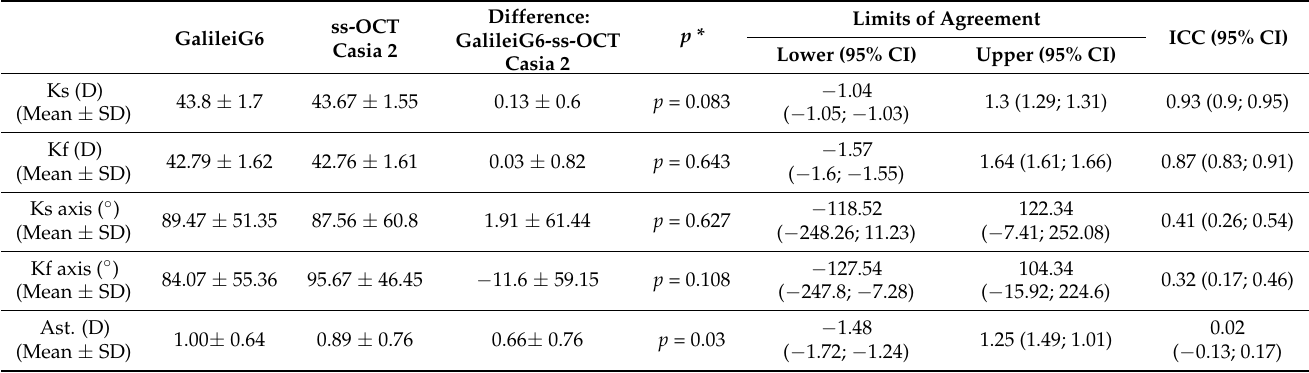
Table 1. Table comparing total Ks(D) and Kf (D), Ks axis ( ◦ ), Kf axis ( ◦ ), total astigmatism As.(D) measured with OCT Casia 2 and GalileiG6 Dual Scheimpflug Analyzer. ICC (introclass correlation coefficient) refers to the correlation between